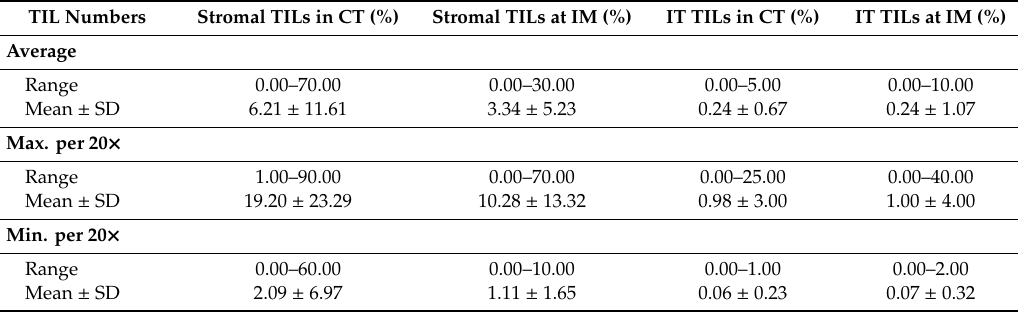
Table 1. Percentages of stromal and intra-tumoral tumor infiltrating